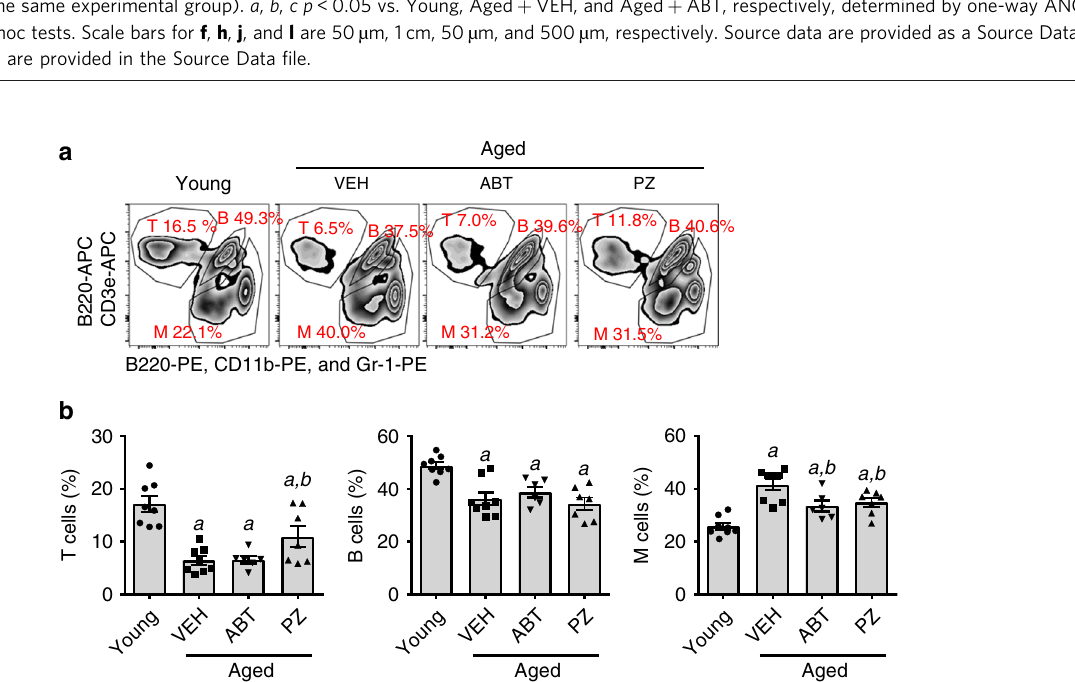
Fig. 5 PZ attenuates age-related myeloid skewing in naturally aged mice. a Representative fl ow cytometric analyses of T cells (CD3e + ), B cells (B220 + ) and myeloid cells (M cells; CD11b/Gr-1 + ) in blood from control untreated young mice (Young) or naturally aged mice treated with vehicle (VEH), ABT263 (ABT) or PZ as shown in Fig. 3b. b The percentages of blood T cells, B cells, and M cells in these mice are presented as mean ± SEM ( n = 8, 8, 6, and 7 mice for Young mice and aged mice with VEH, ABT, and PZ treatment, respectively). a , b p < 0.05 vs. Young and Aged + VEH, respectively, determined by one- way ANOVA with Tukey ’ s or Dunnett ’ s post-hoc tests. Source data are provided as a Source Data fi le. The exact P values are provided in the Source Data fi